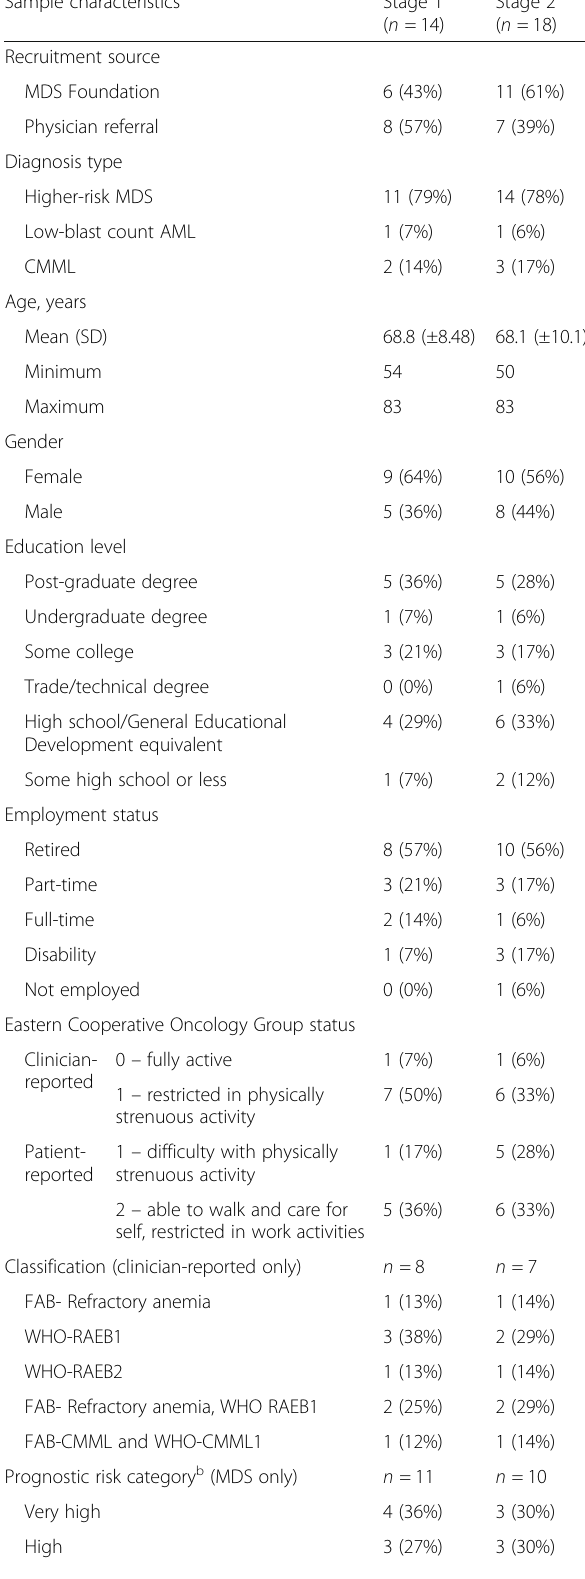
Table 1 Patient demographic and clinical characteristics